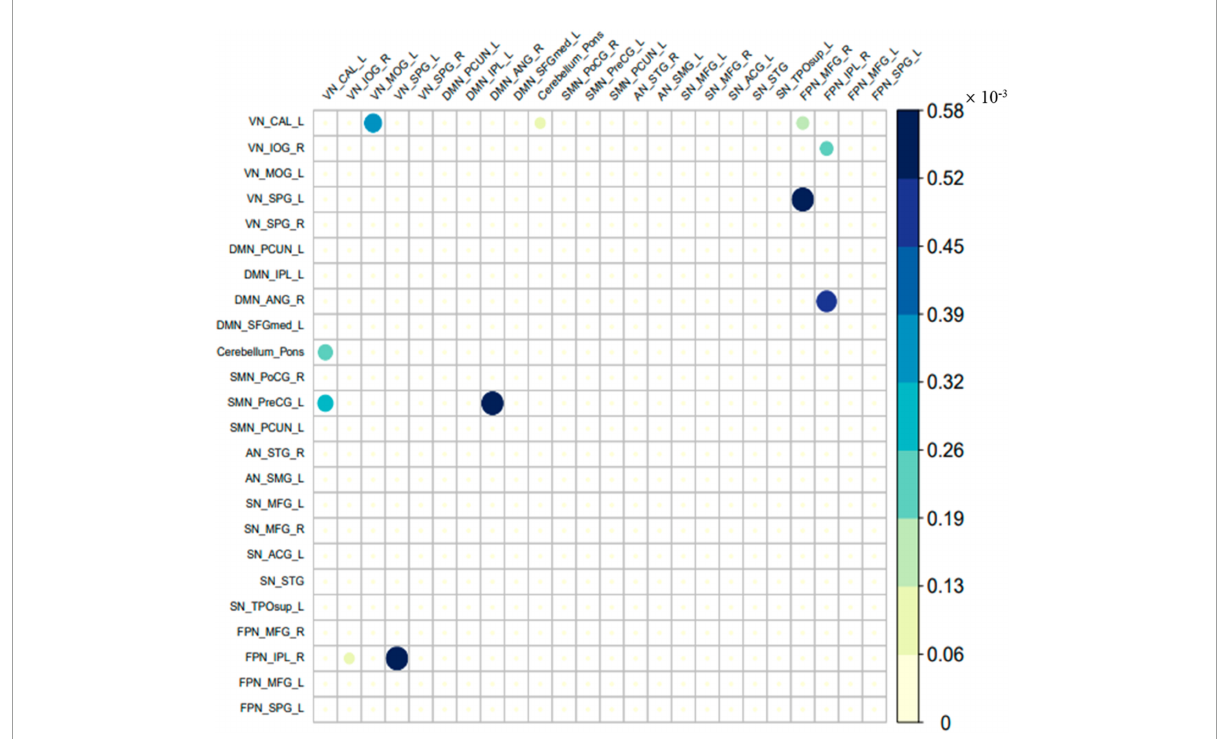
FIGURE4 The different part of the effective connectivity between the two groups. The size of the circle indicates the size of the effective connectivity value.